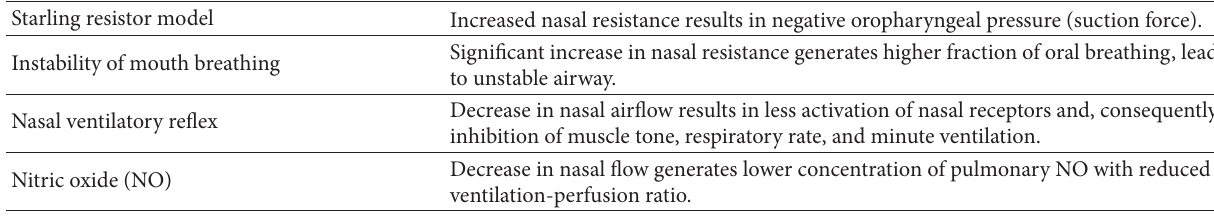
Table 1: Nasal pathophysiology in the pathogenesis of